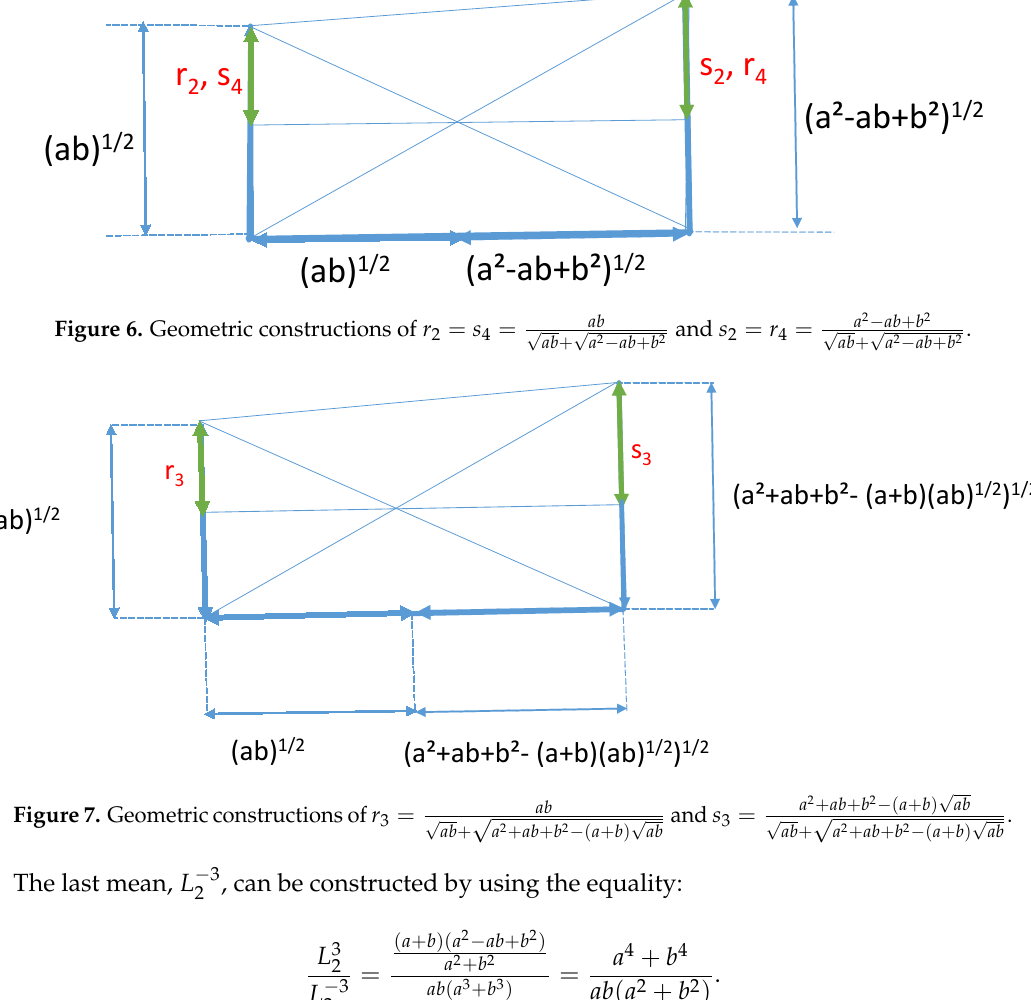
Figure 7: Geometric constructions of r